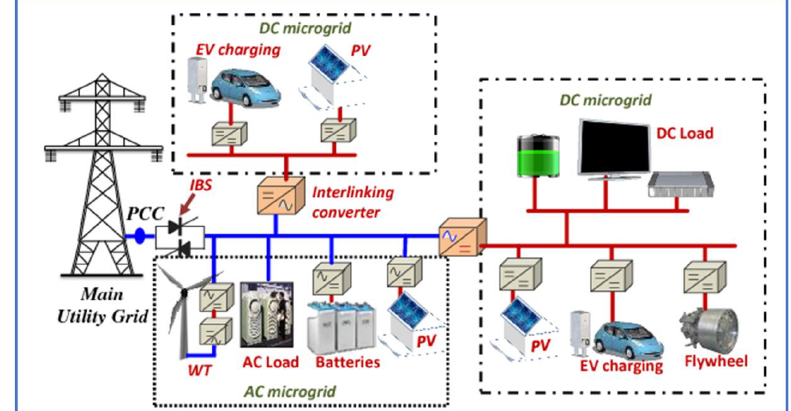
Figure 4. Hybrid MG architecture